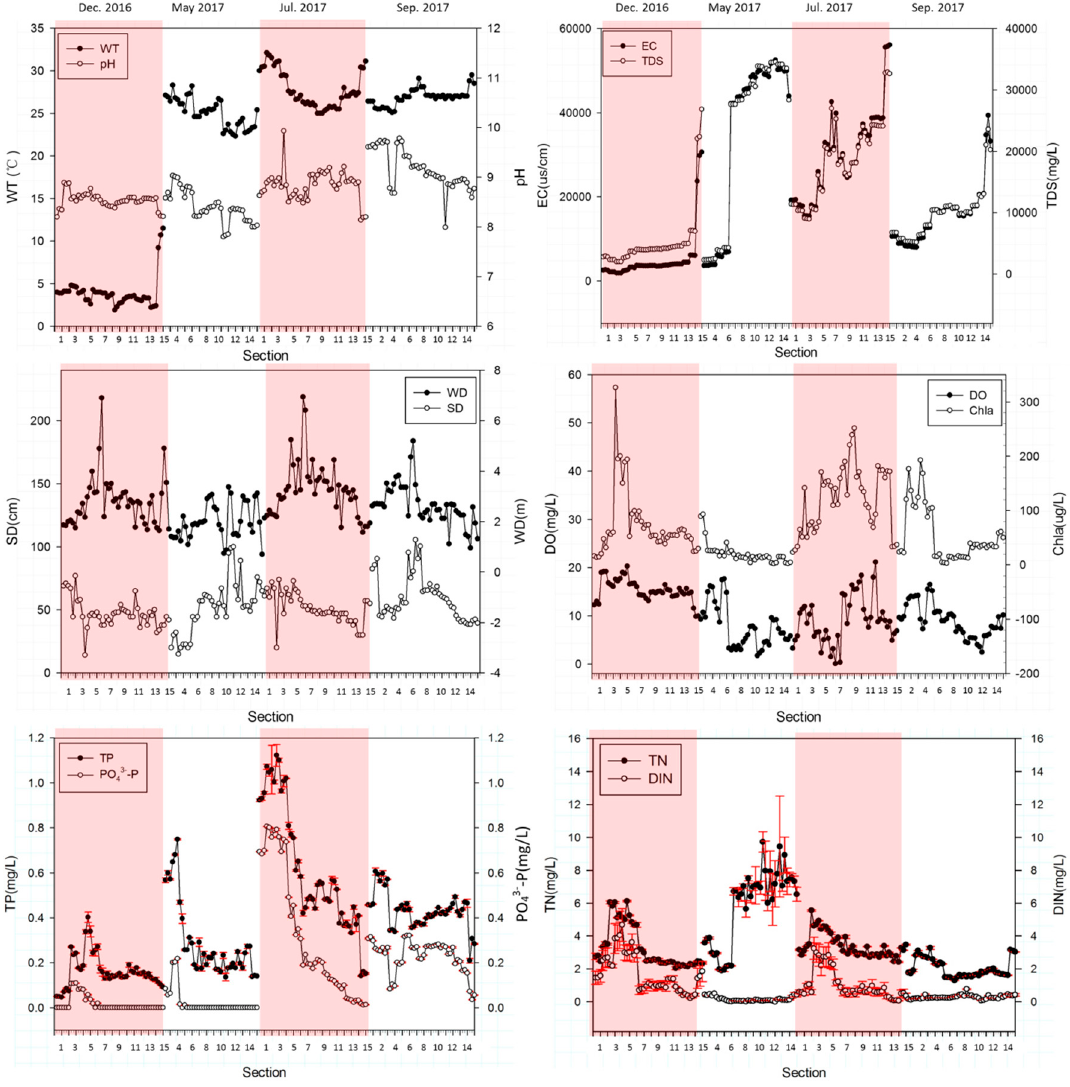
Figure 2. Spatial and temporal variability of water quality in the Duliujian River. Note: The major ticks of the x -axis are the third site at each section, and the minor ticks before each major ticks are the first and second site. i.e., the major tick number 1 means S1.3, two minor ticks before number 1 means S1.1, S1.2. The major tick labels are also corresponding to their section number.